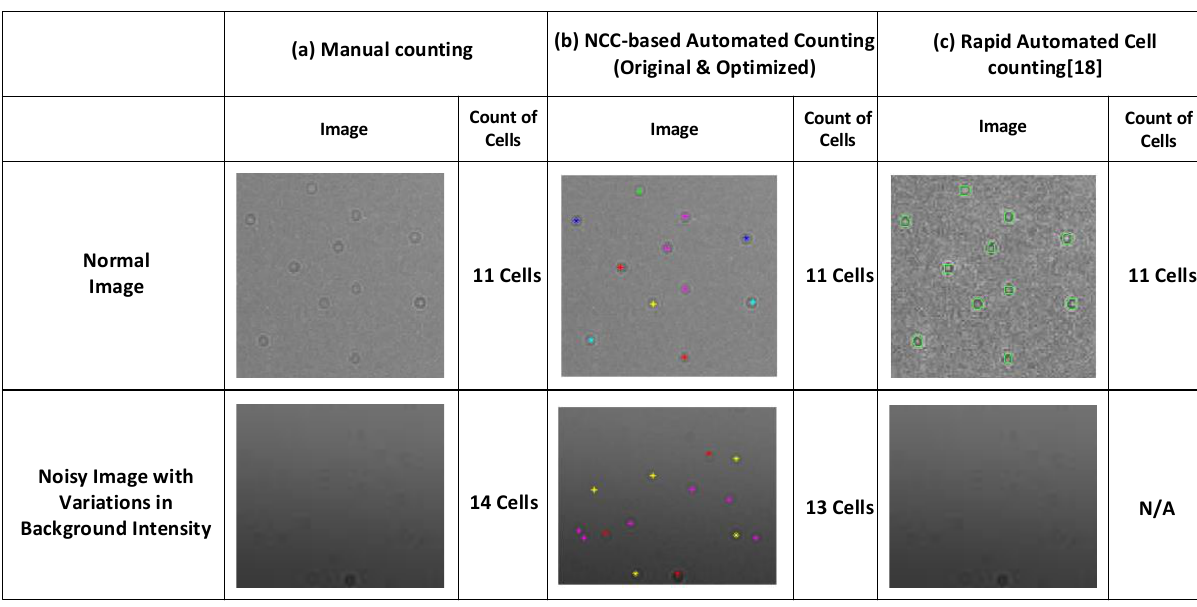
Figure 7. Comparison with manual counting and another cell counting algorithm [18]. With normal blood sample images, all three methods have the same results. For noisy images with intensity variations, NCC-based algorithms (both original and optimized) produce counting results close to those of manual counting, while [18] fails to reliably count